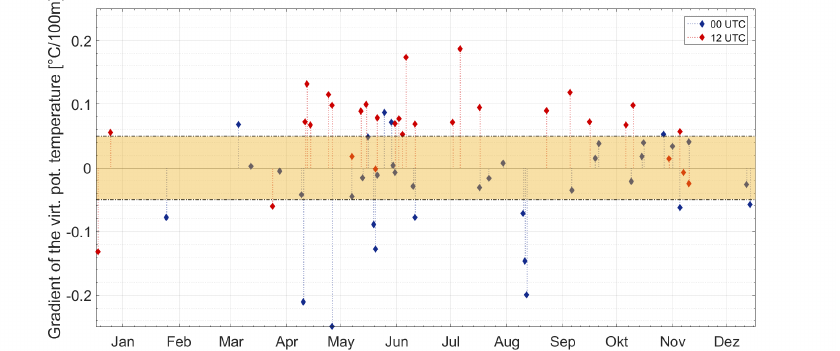
Figure 7. LLJ events depending on the vertical gradient of the potential temperature based on radiosonde data from 9 August 2019 to 8 August 2020. The radiosonde ascents at midnight are indicated by a blue symbol, and the ascents around noon by a red symbol. The yellow horizontal bar indicates an (arbitrary) range of very small changes in virtual potential temperature, separating cases with clearly stable conditions (above) and clearly unstable conditions (below).